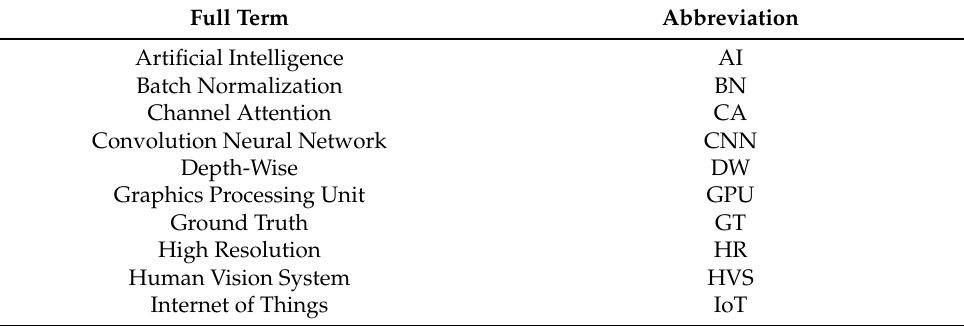
Table 12. List of abbreviations used in this